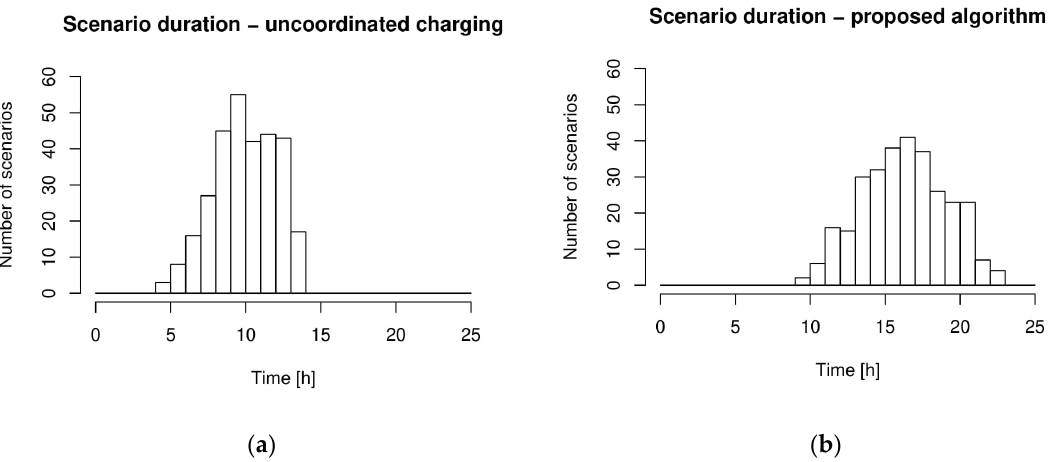
Figure 8. A summary of simulated scenario duration. ( a ) Without the proposed algorithm. ( b ) With the proposed algorithm.